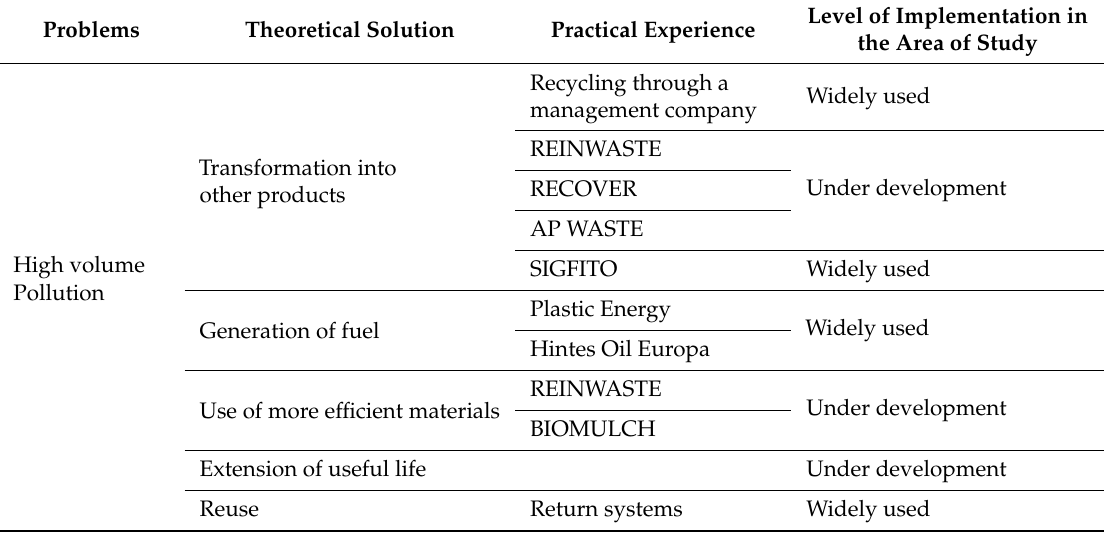
Table 4. Main solutions based on the CE for plastic